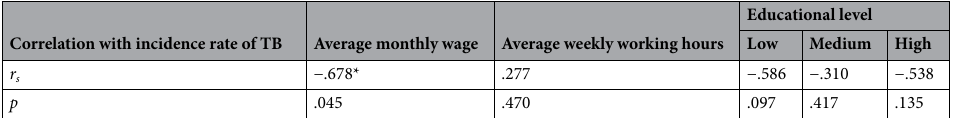
Correlation with incidence rate of TB Average monthly wage Average weekly working hours